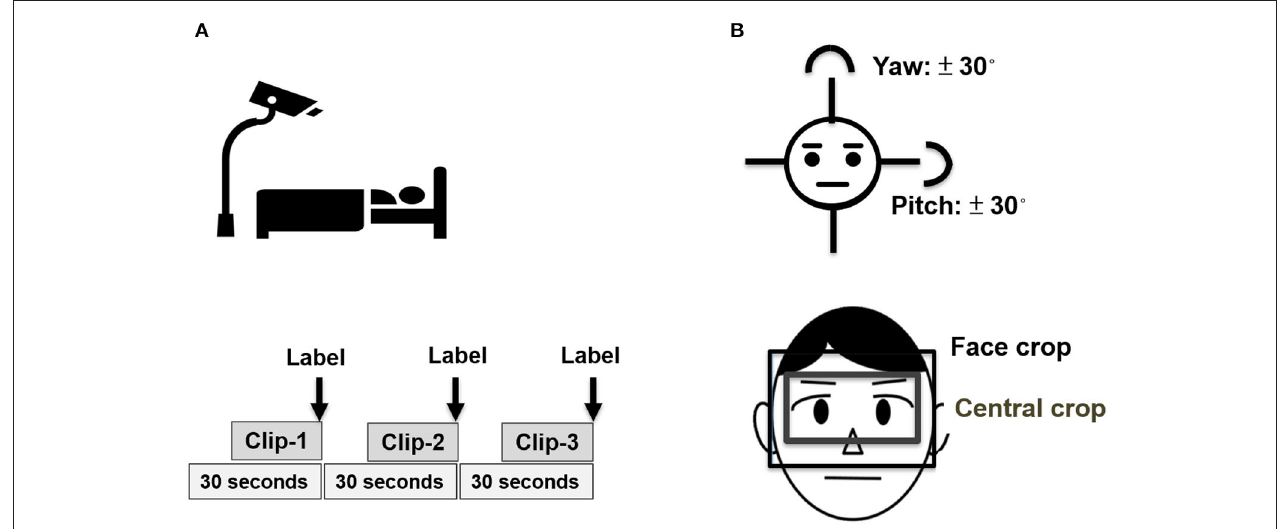
FIGURE 1 | Schematic diagram of image acquisition and preprocessing. (A) Recording of video clips with labeling and (B) Preprocessing of video